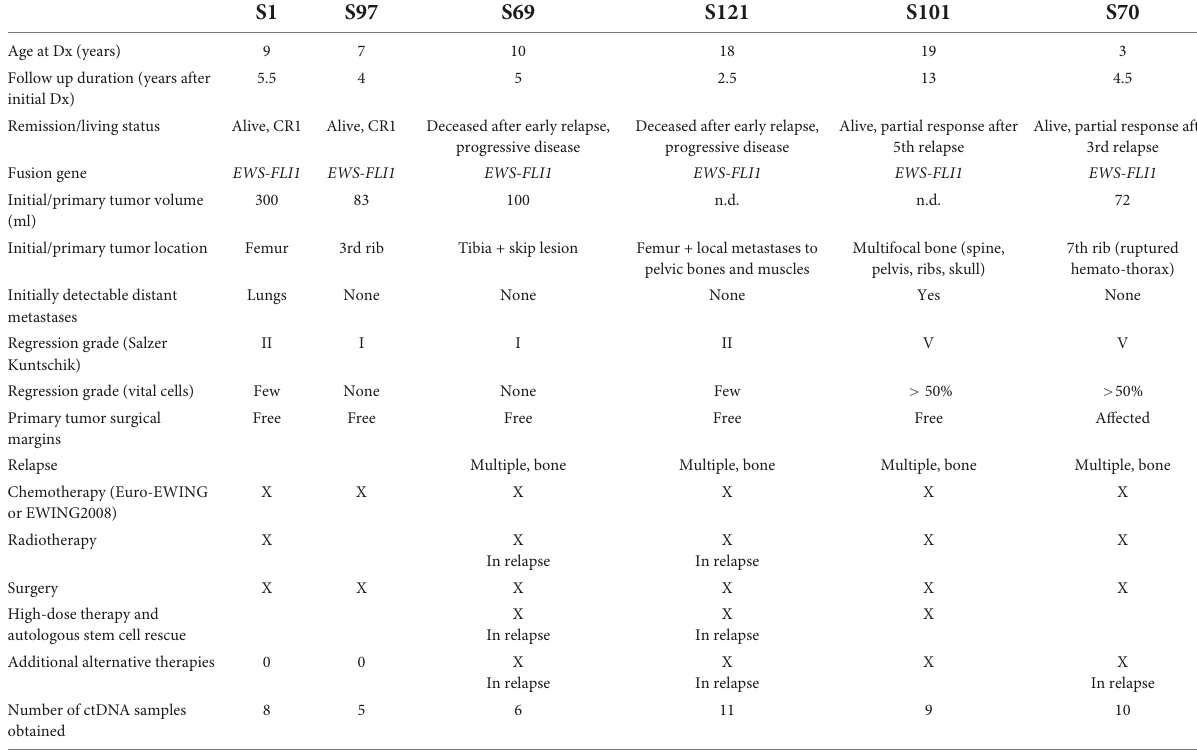
TABLE 2 Patient and tumor